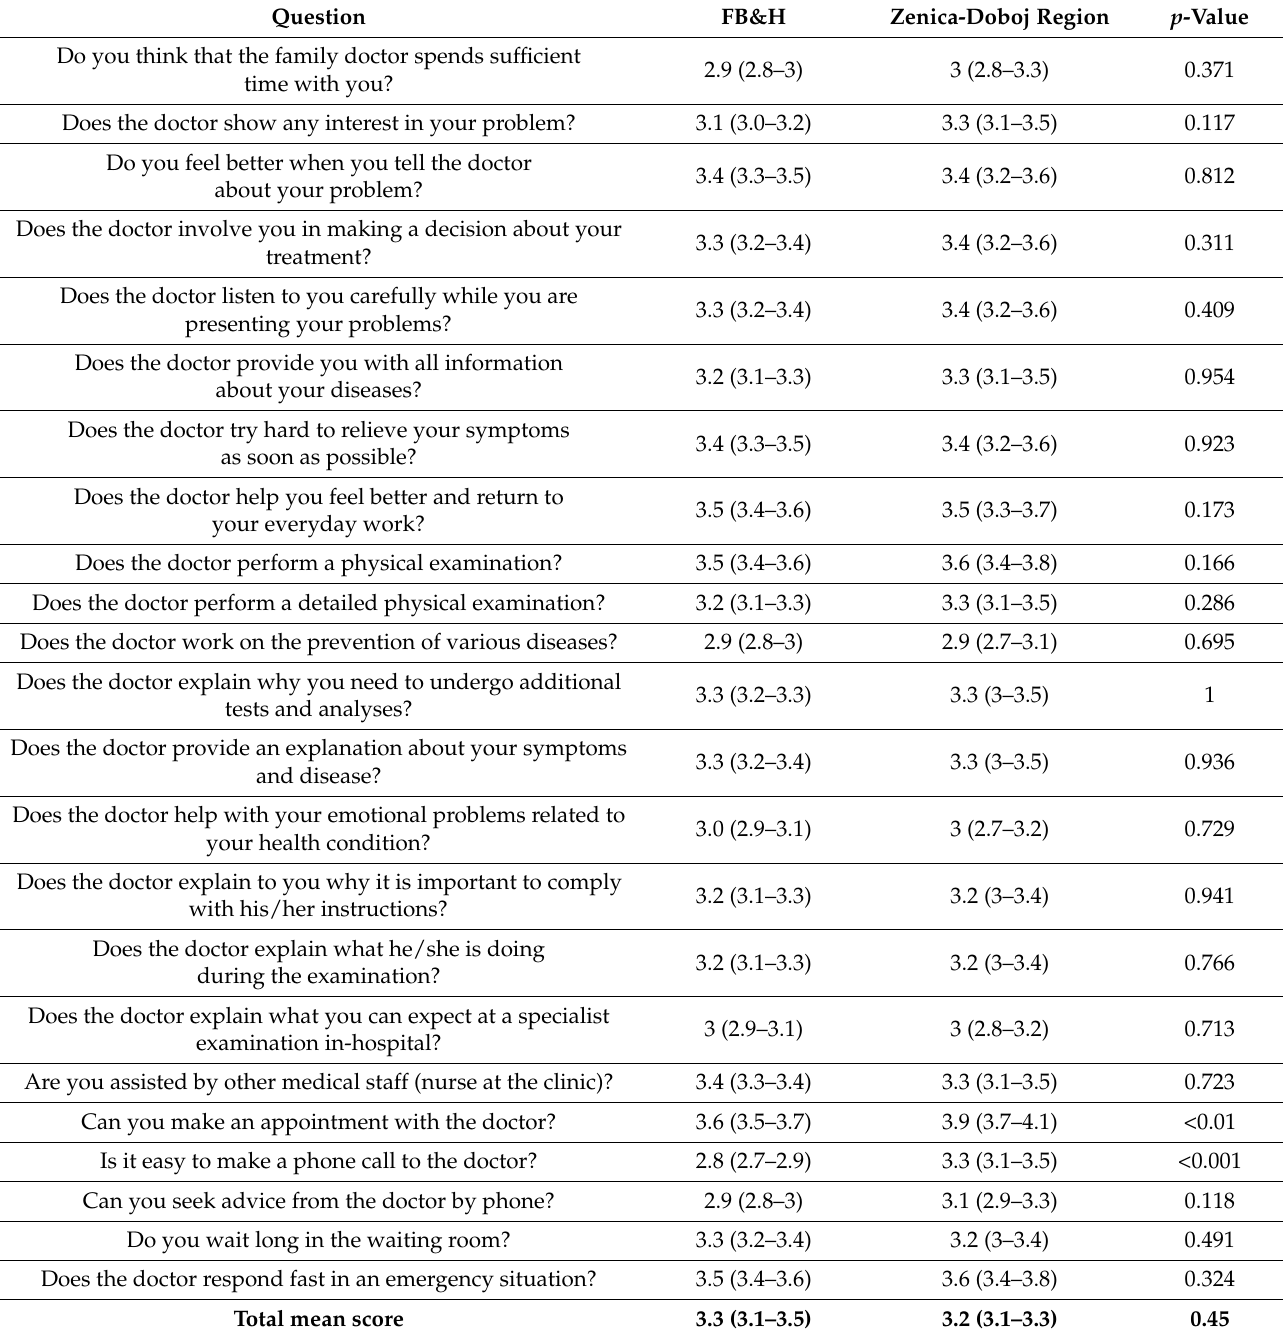
Table 5. Satisfaction with health care in the adult population of the Federation of Bosnia and Herze- govina compared with the region of Zenica-Doboj during the COVID-19 pandemic by age group. Question FB&H Zenica-Doboj Region p